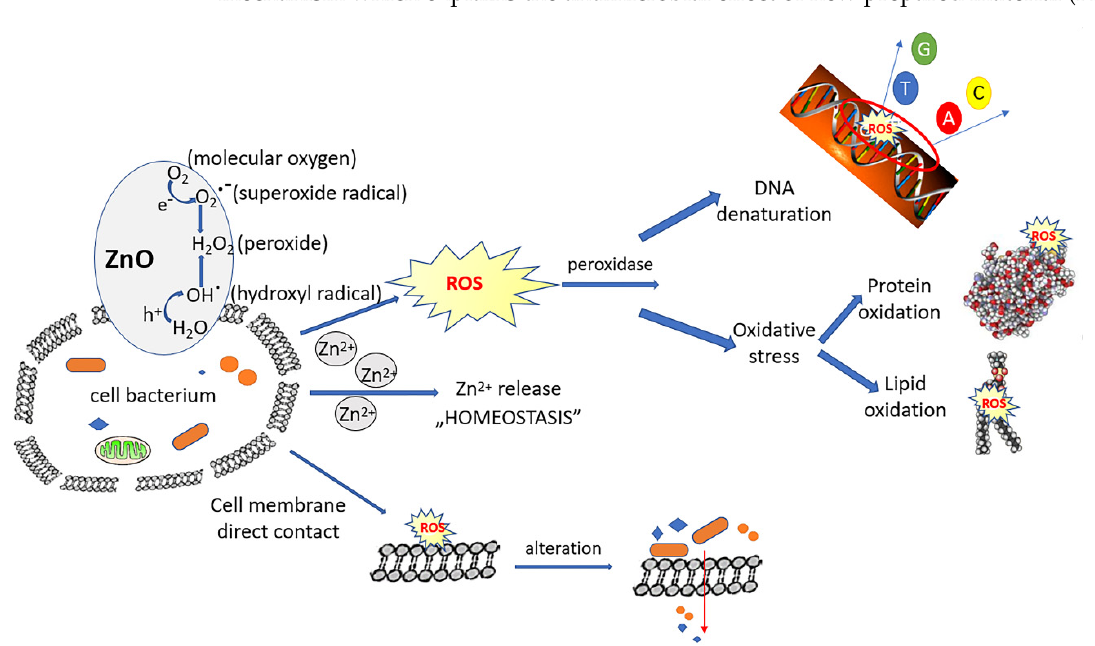
Figure 8. Proposed mechanism for antimicrobial effect.